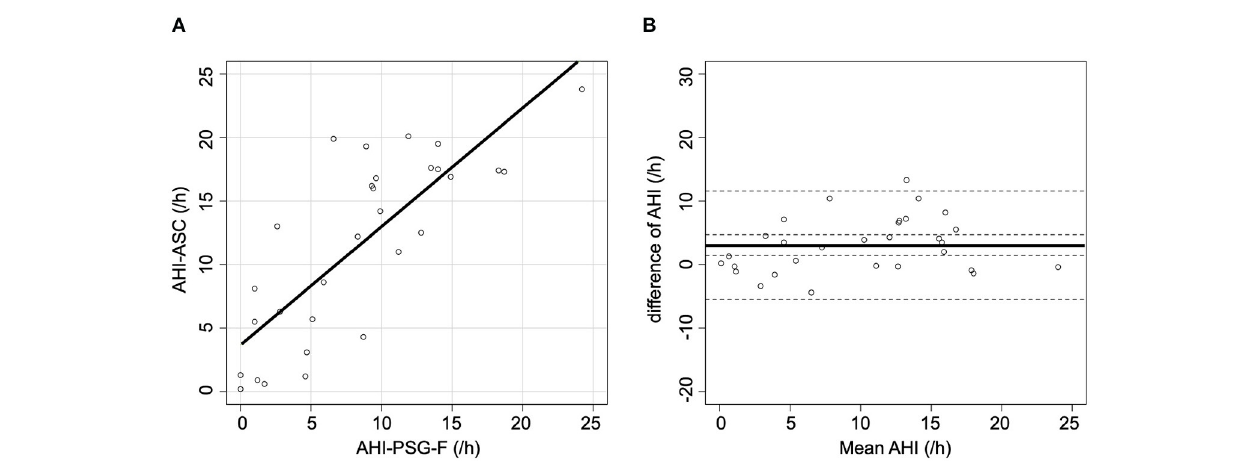
FIGURE 3 | Scatter and Bland-Altman plots comparing AHI-PSG-F and AHI-ASC. (A) There was a moderately strong correlation between AHI-PSG-F and AHI-ASC. (B) The Y-axis indicates the difference between AHI-PSG-F and AHI-ASC [(AHI-PSG-F)–(AHI-ASC)]. The X-axis indicates the mean values. The solid line represents the mean difference, while the dashed lines represent the limit of agreement ( ± 2